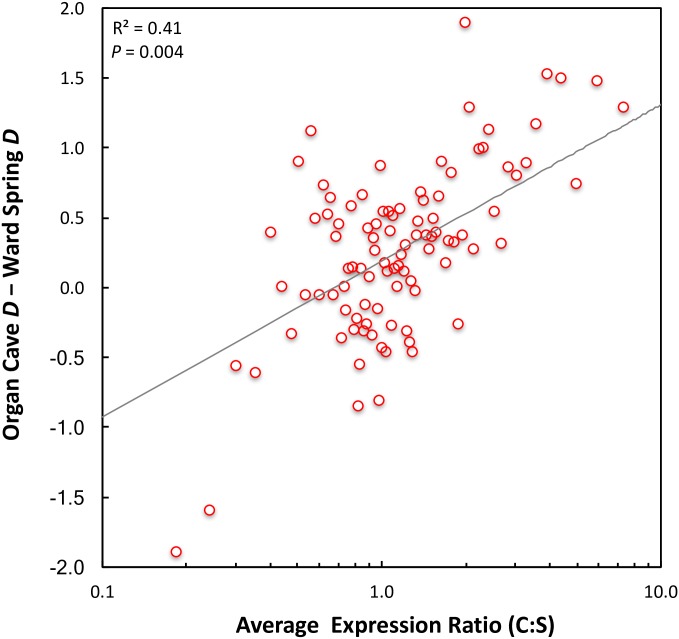
Difference in Tajima’s D (Organ Cave—Ward Spring) versus average expression ratio for binned data.Expression data for the 37,567 unigenes were binned in 1% intervals (~376 unigenes per bin) according to their cave:surface expression ratios. Each of the 100 data points in the plot consists of the average expression ratio in the bin (X-axis, log10 scale), and the average difference in Tajima’s D (y-axis). The least squares regression is shown in grey, had a coefficient of determination of 0.42 and the slope of the regression line is significantly positive (P < 0.01), indicating a positive relationship between ΔD and average expression ratio.